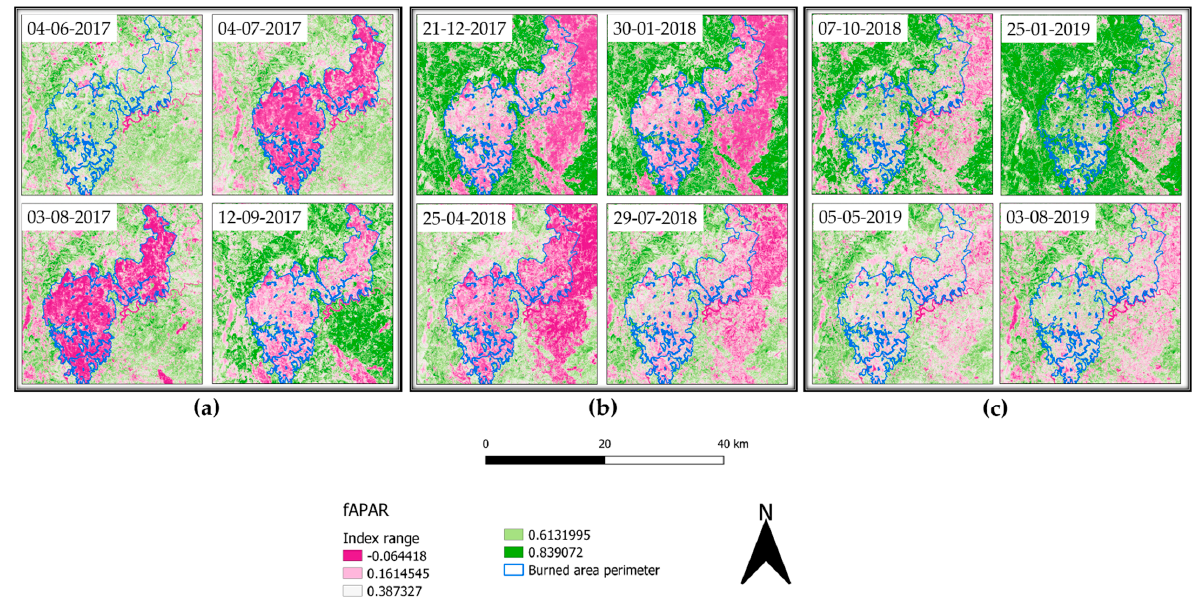
Figure 9. fAPAR representation from 4 June 2017 to 3 August 2019.